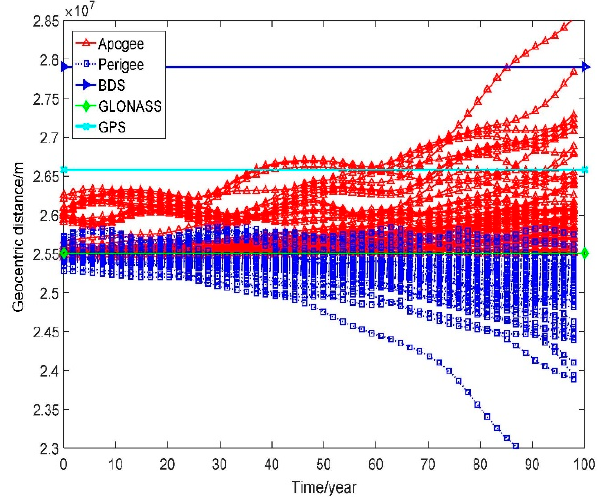
Figure 12. Orbital variations of GLONASS spent upper stages over 100 years.